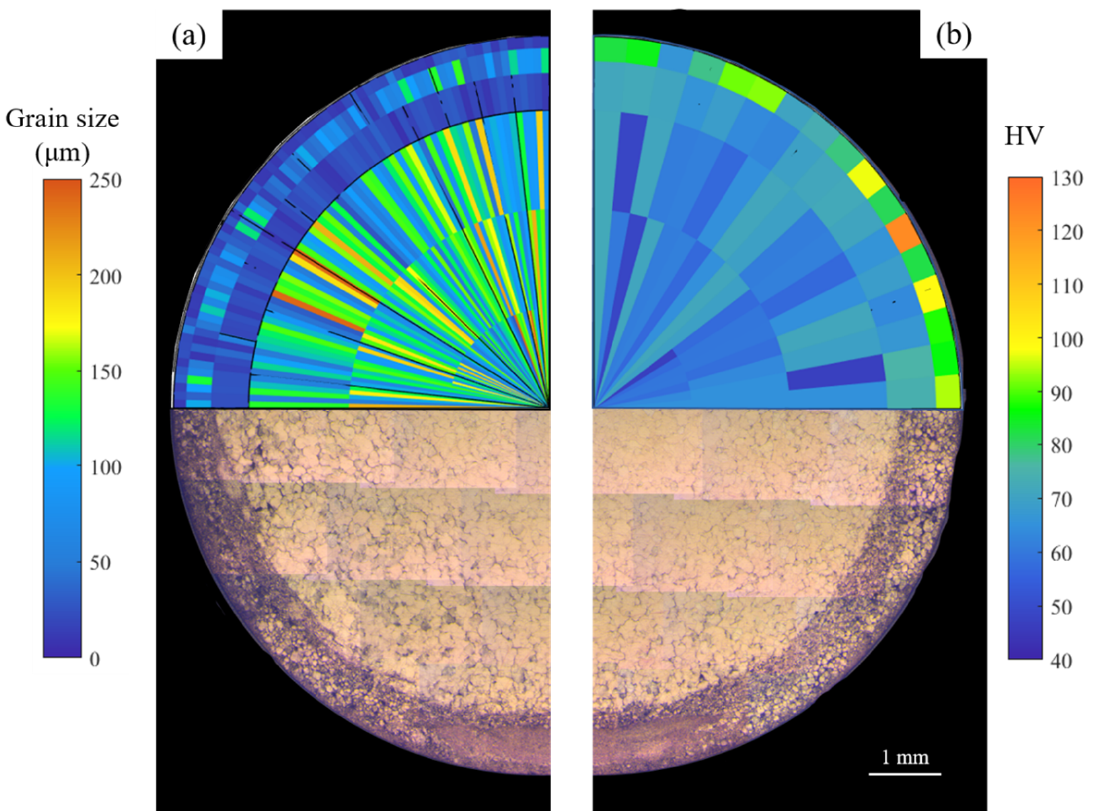
Figure 10. Variation of ( a ) grain size and ( b ) Vickers microhardness of different regions in the rod cross-section (ND1-ND2 plane).